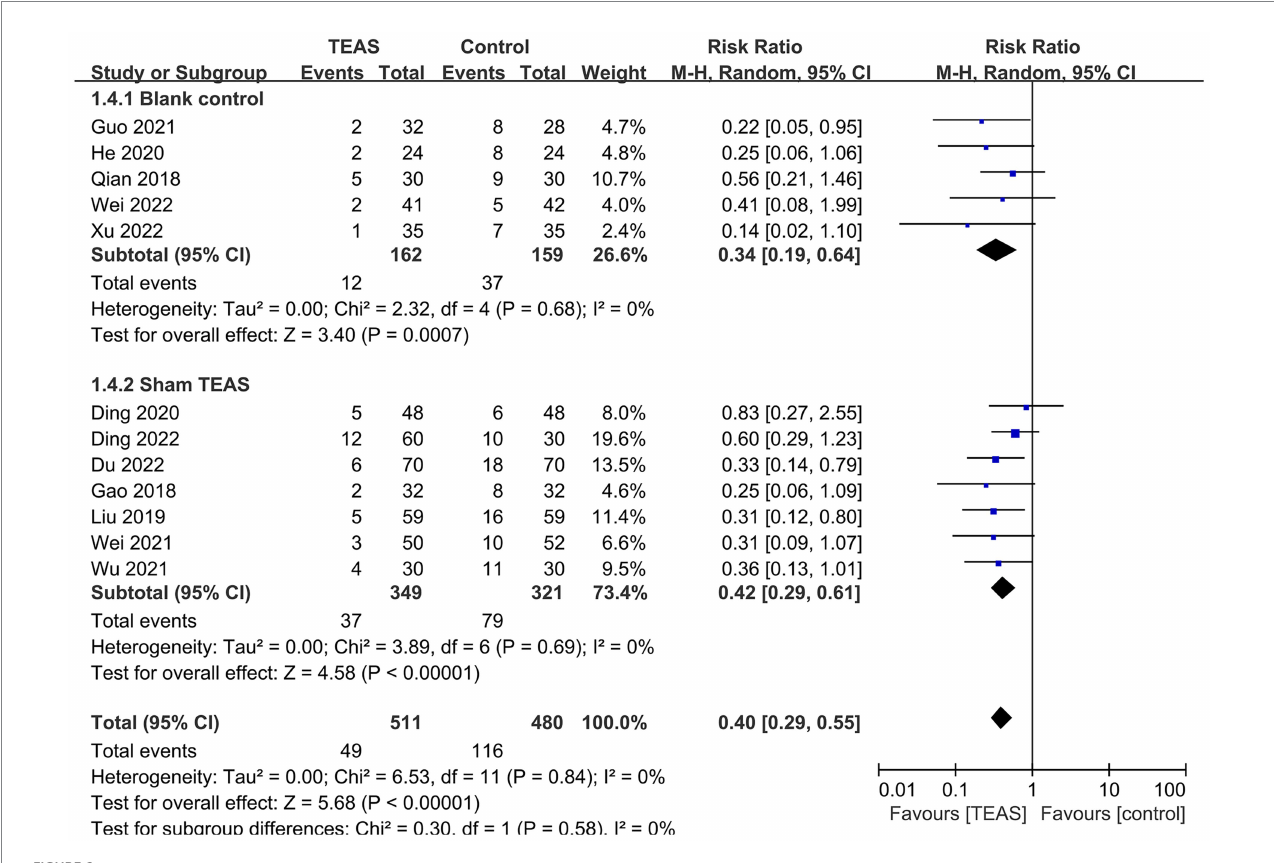
FIGURE 6 Subgroup analysis of the incidence of POD based on different control interventions.